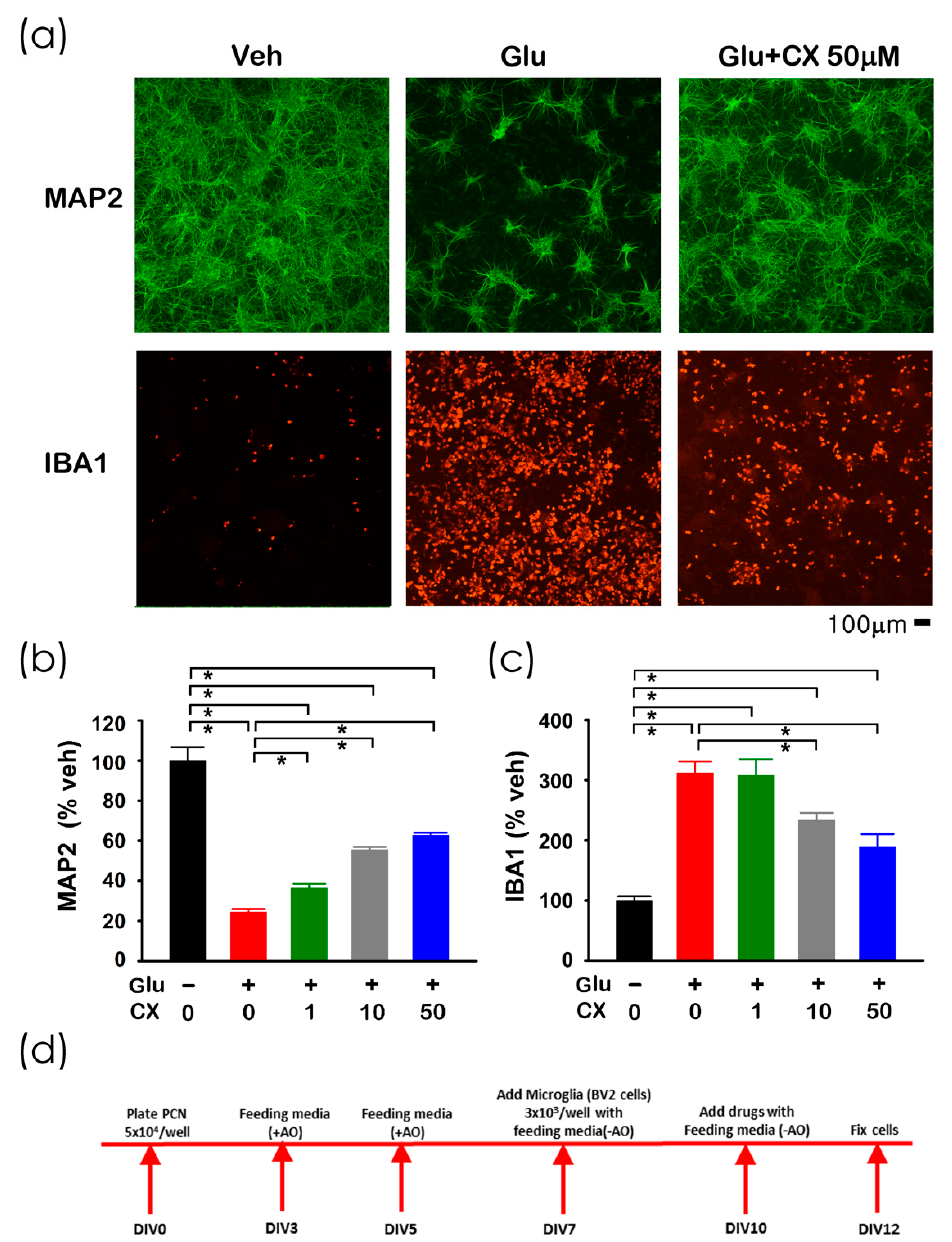
Figure 2. CX807 antagonized Glu-mediated neuronal loss and microglia activation in primary cortical neuronal and BV2 microglial co-culture. ( a ) Treatment with glutamate (Glu) reduced MAP2 (in green color) while increasing IBA1 (red) immunoreactivity in microglia and neurons co-culture. CX807 antagonized both responses. Calibration = 100 µ m. Immunoreactivity of MAP2 ( b ) and IBA1 ( c ) were normalized to the mean of the control samples. CX807 (1–50 µ M) significantly antagonized glutamate (100 µ M)-mediated changes in MAP2 and IBA1 immunoreactivity. ( d ) Timeline of the experiment. Data are represented as mean +/ − SEM. * p < 0.05, 1-Way ANOVA on rank + post-hoc NK